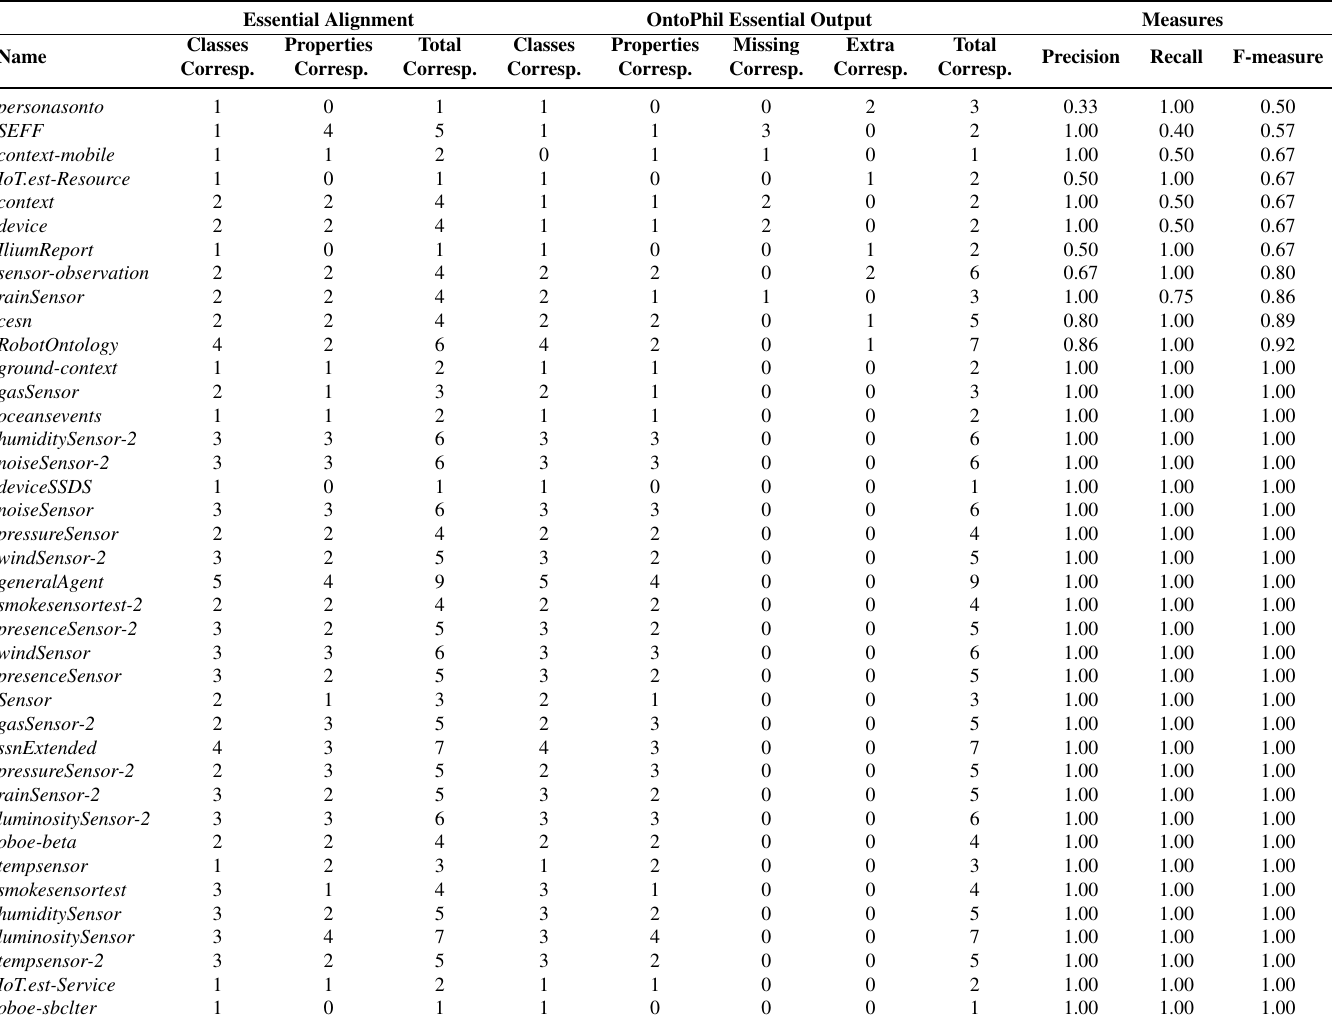
Table 9. Results obtained using the essential reference